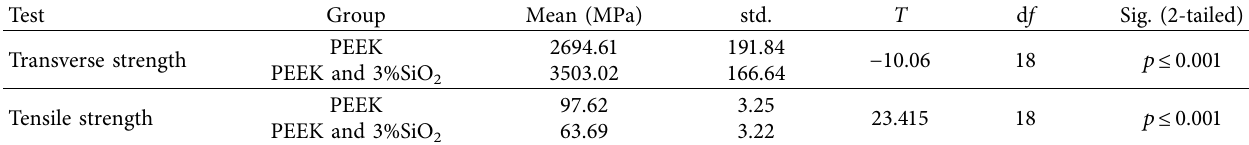
Table 1: Mean values and standard deviation of transverse strength MPa tensile strength MPa with Independent T -Test. Test Group Transverse